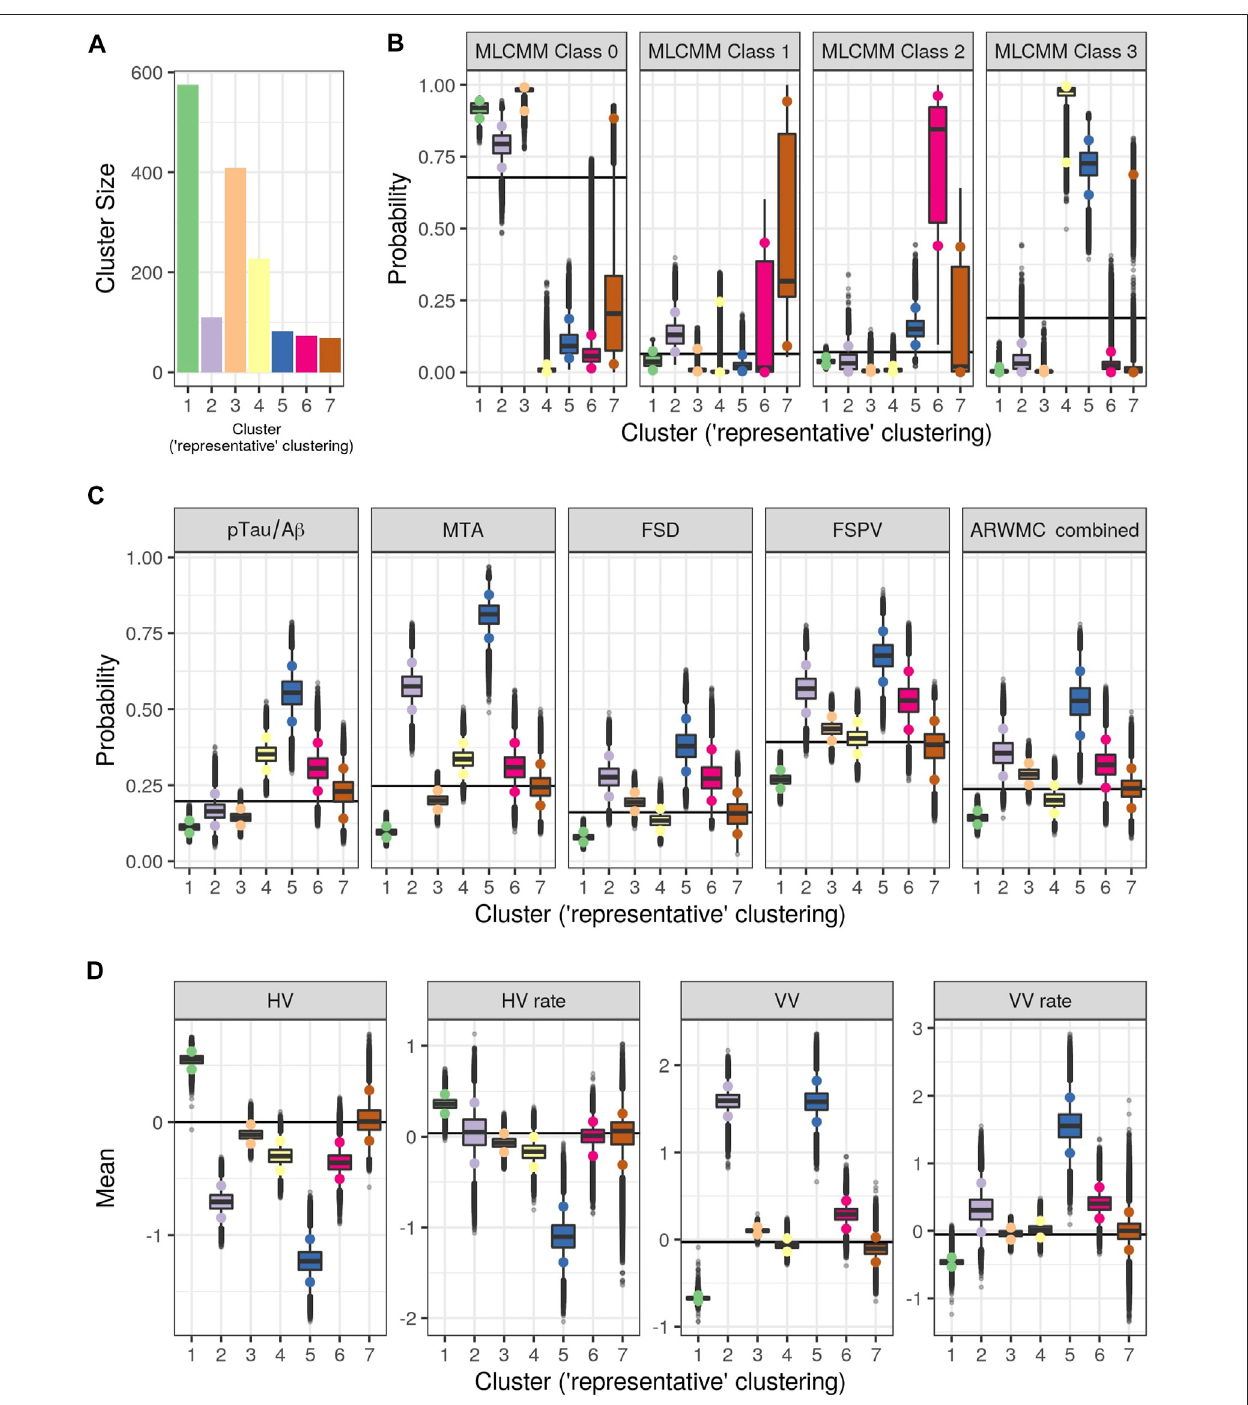
FIGURE 4 | Results from Bayesian Pro fi le Regression analysis. (A) Cluster sizes for the fi nal PAM representative consensus clusters. (B – D) Posterior distributions for mean mixture component parameter values for each of the “ representative ” clusters (see Section 2.2.2). (B) Outcome variable (parameters are the probability of belonging to each MLCMM latent class). (C) Binary covariates (parameters are the probability of the covariate having value of one). (D) Continuous covariates (parameters are the mean covariate value). For (A – D) , colors indicate clusters (see also Figure 3 ). For (B – D) , black horizontal lines indicate the mean parameter values across all subjects and the coloured circles indicate the upper and lower limit of the 90% credible interval.